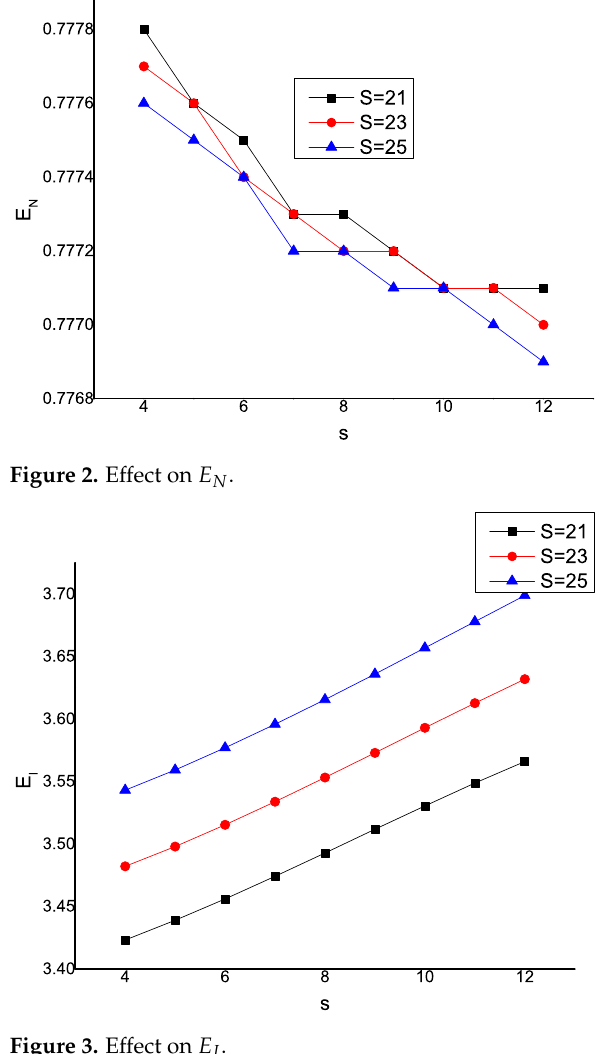
Figure 3. Effect on E I . Table 5. Effect of s and S for ( c , δ , λ , µ , η ) = ( 3,0.8,4,7,2.6 )